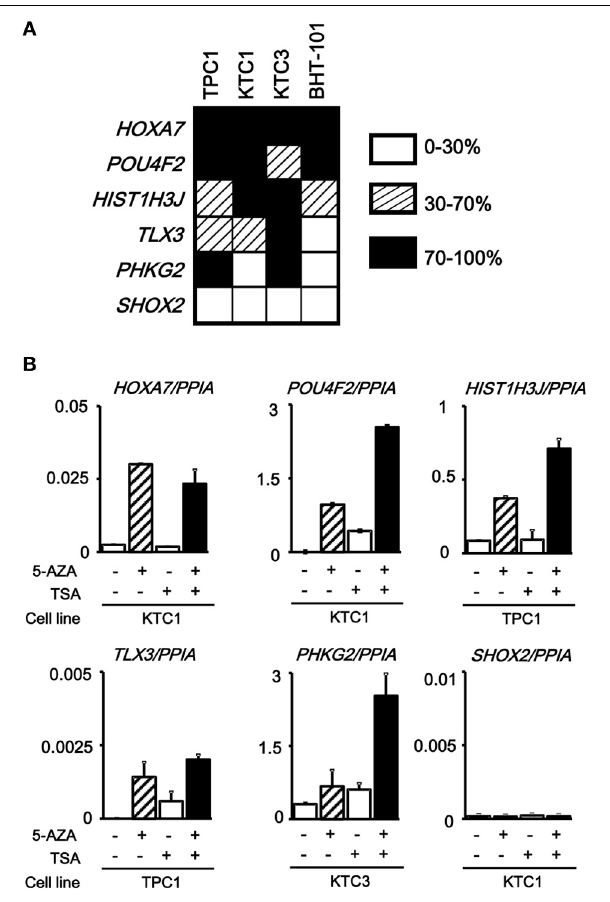
FIGURE 5 | Silencing of aberrantly methylated genes. (A) Methylation status of the HOXA7 , POU4F2 , HIST1H3J , TLX3 , PHKG2 , SHOX2 genes was analyzed in papillary thyroid cancer cell lines TPC1, KTC1, and KTC3 and anaplastic thyroid cancer cell line BHT-101 by pyrosequencing. Open box , 0–30% methylation, presumably no allele methylation. Hatched box , 30–70% methylation, presumably hemi-allelic or partial methylation. Closed box , 70–100% methylation, presumably bi-allelic and dense methylation. All the genes except SHOX2 showed dense methylation in at least one papillary thyroid cancer cell line. (B) Real-time RT-PCR analysis of the methylated genes. Cells were treated with 5-aza-2 (cid:2) -deoxycytidine (5-AZA) and/or trichostatin A (TSA). Gene expression levels were normalized to that of PPIA ( Peptidylprolyl Isomerase A , or cyclophilin A ). All the genes except SHOX2 showed no or very low expression in the analyzed cancer cell line, and showed re-expression in cells treated with